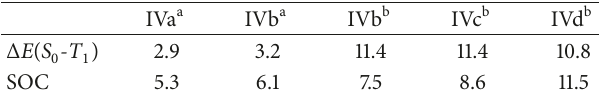
Table2:Adiabatic S 0 - T 1 energygaps( Δ E ( S 0 - T 1 ),inkcal mol −1 )and vertical ionization energies (IE, in kcal mol −1 ) and electron